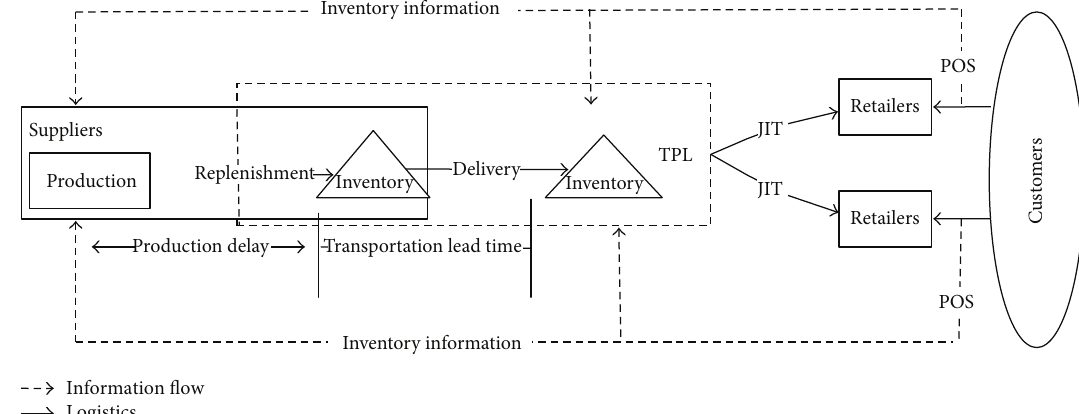
Figure 8: VMI&TPL-APIOBPCS integrated operating model.